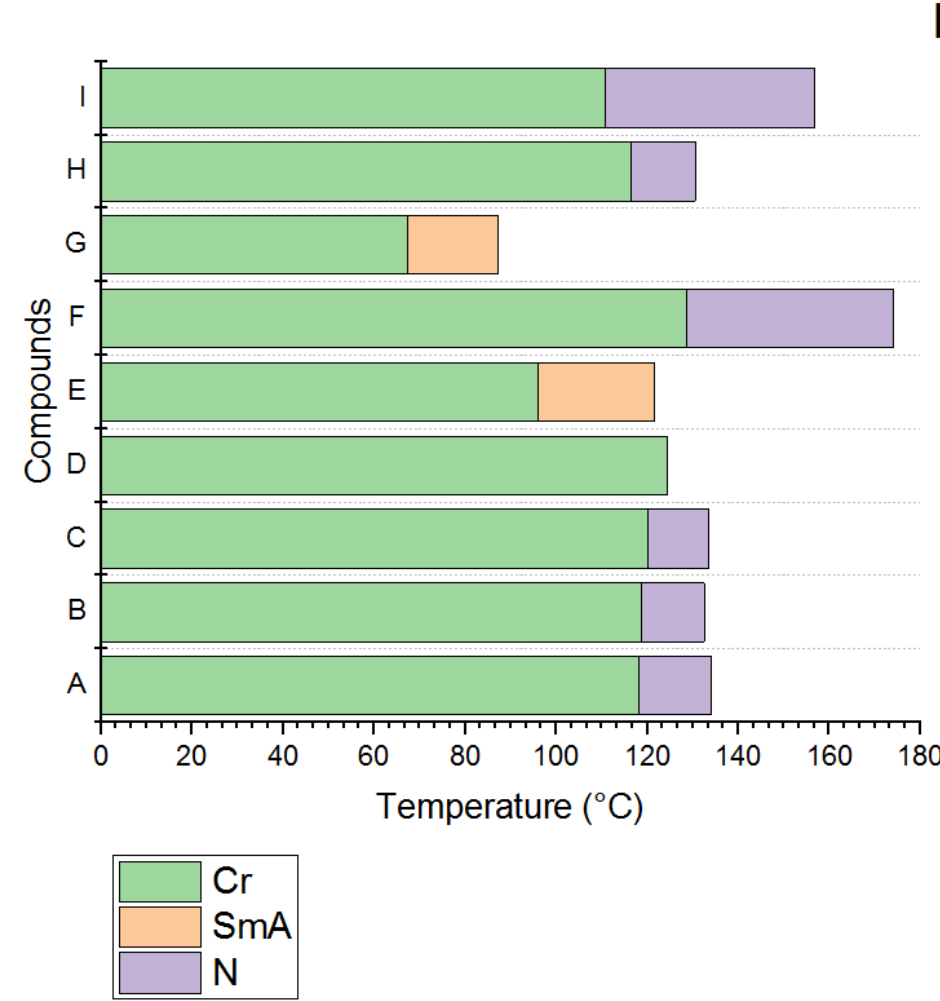
Figure 4. Graphical representations of ( a ) mesophase ranges of all investigated compounds A , B , C , D , E , F , G , H , and I ; ( b ) mesophase temperatures in terms of the compounds.